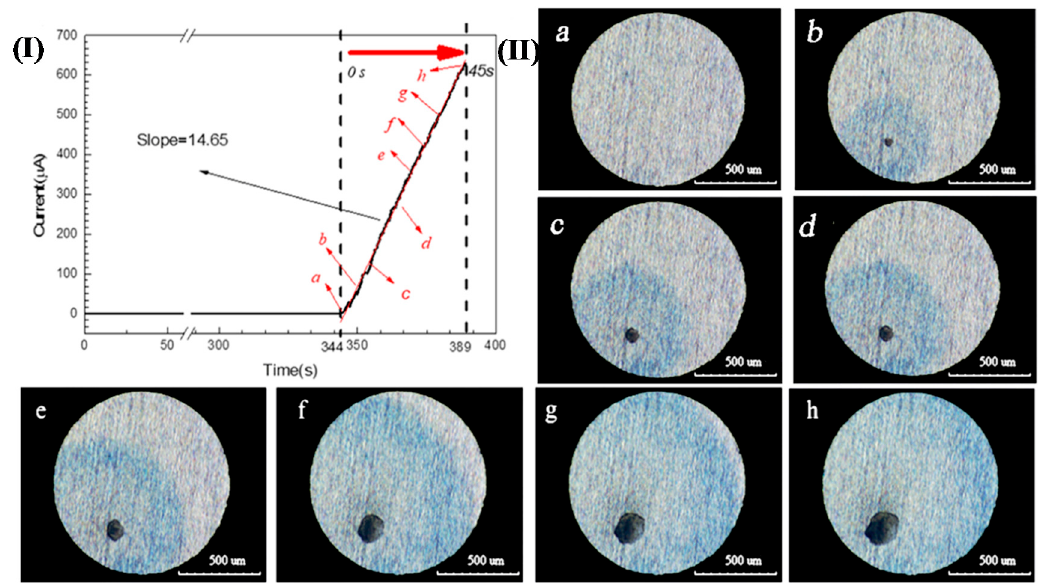
Figure 2. ( Ⅰ ). Chrono amperometry curve of 304 SS in a 3.5 wt.% NaCl and 0.05 wt.% K 3 [Fe(CN) 6 ] solution at 0.35 V(SCE); ( Ⅱ ). Images of the growth of a single pit over time corresponding to Figure 2( Ⅰ ): ( a ) 0 s, ( b ) 5 s, ( c ) 10 s, ( d ) 20s, ( e ) 30 s, ( f ) 35 s, ( g ) 40 s, and ( h ) 45 s.